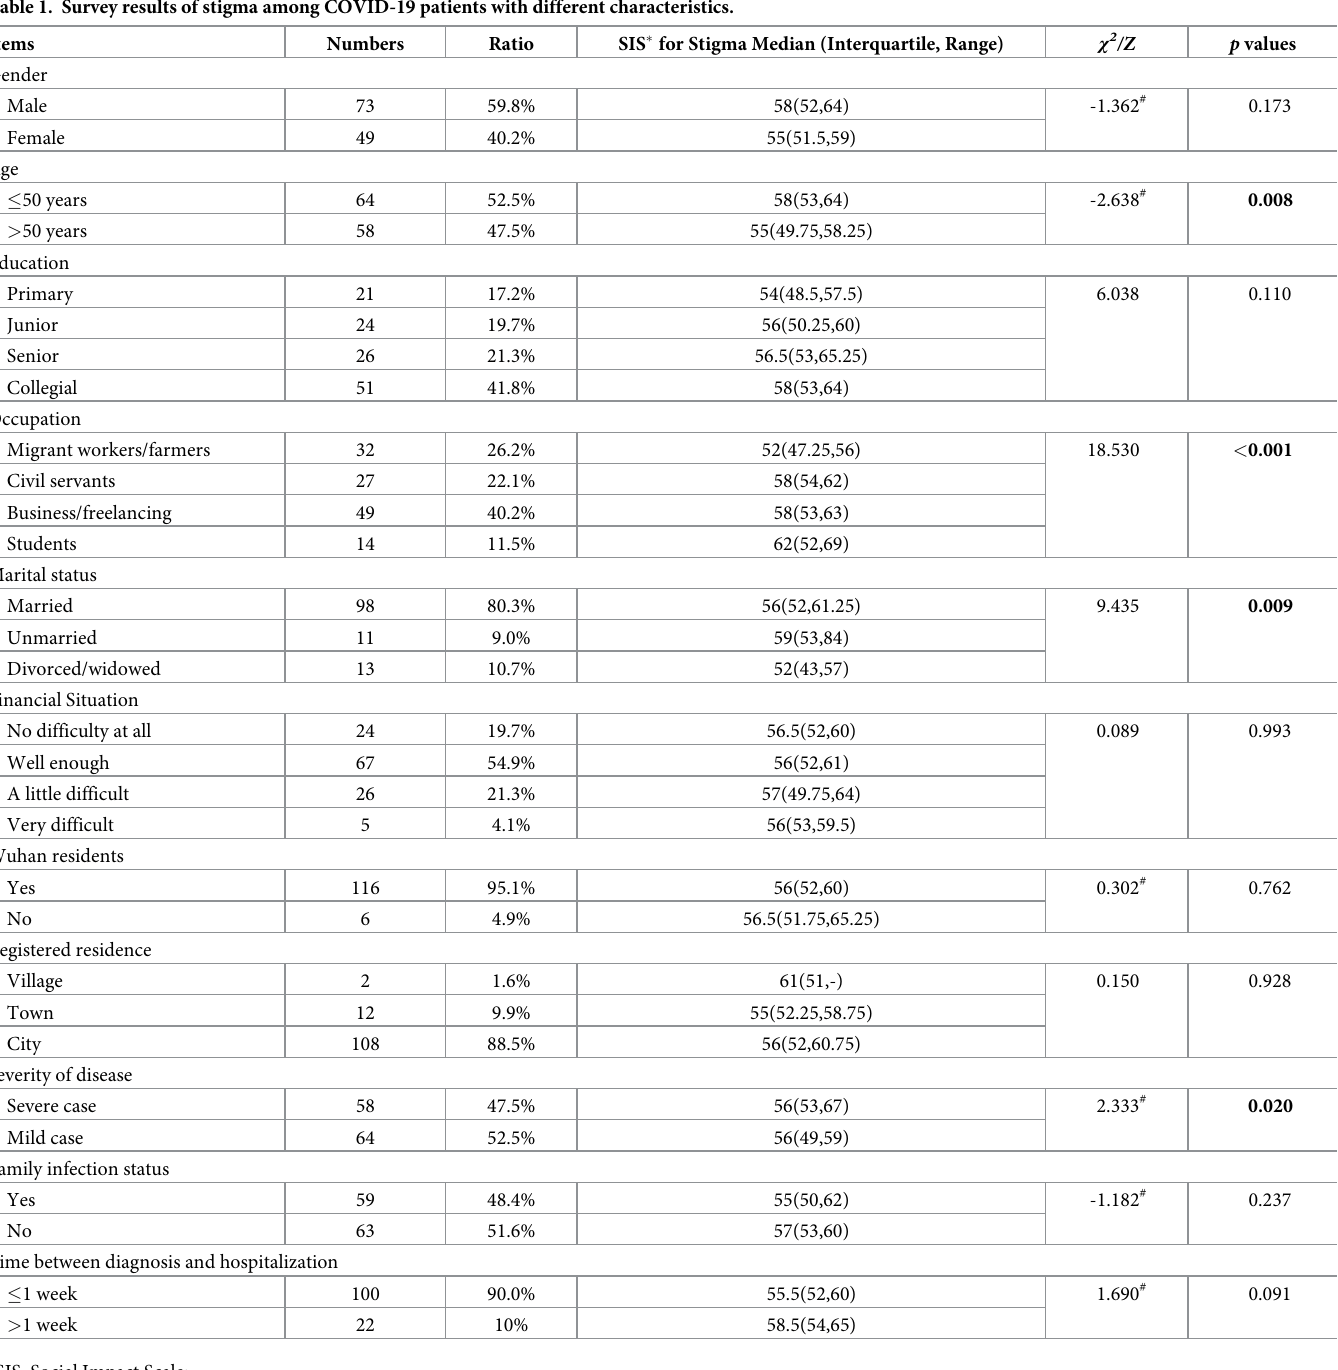
Table 1. Survey results of stigma among COVID-19 patients with different